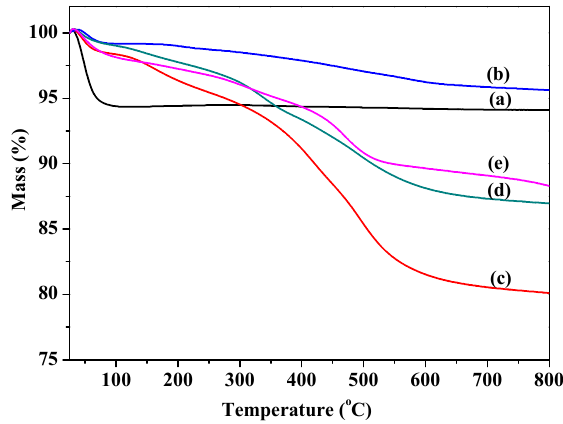
Figure 2. Thermogravimetric curves of ( a ) SiO 2 ; ( b ) SiO 2 -Cl; ( c ) SiO 2 -Im; ( d ) SiO 2 Im + Cl − SiO 2 ; and ( e ) PW(0.058)/SiO 2 Im + Cl − SiO 2 .